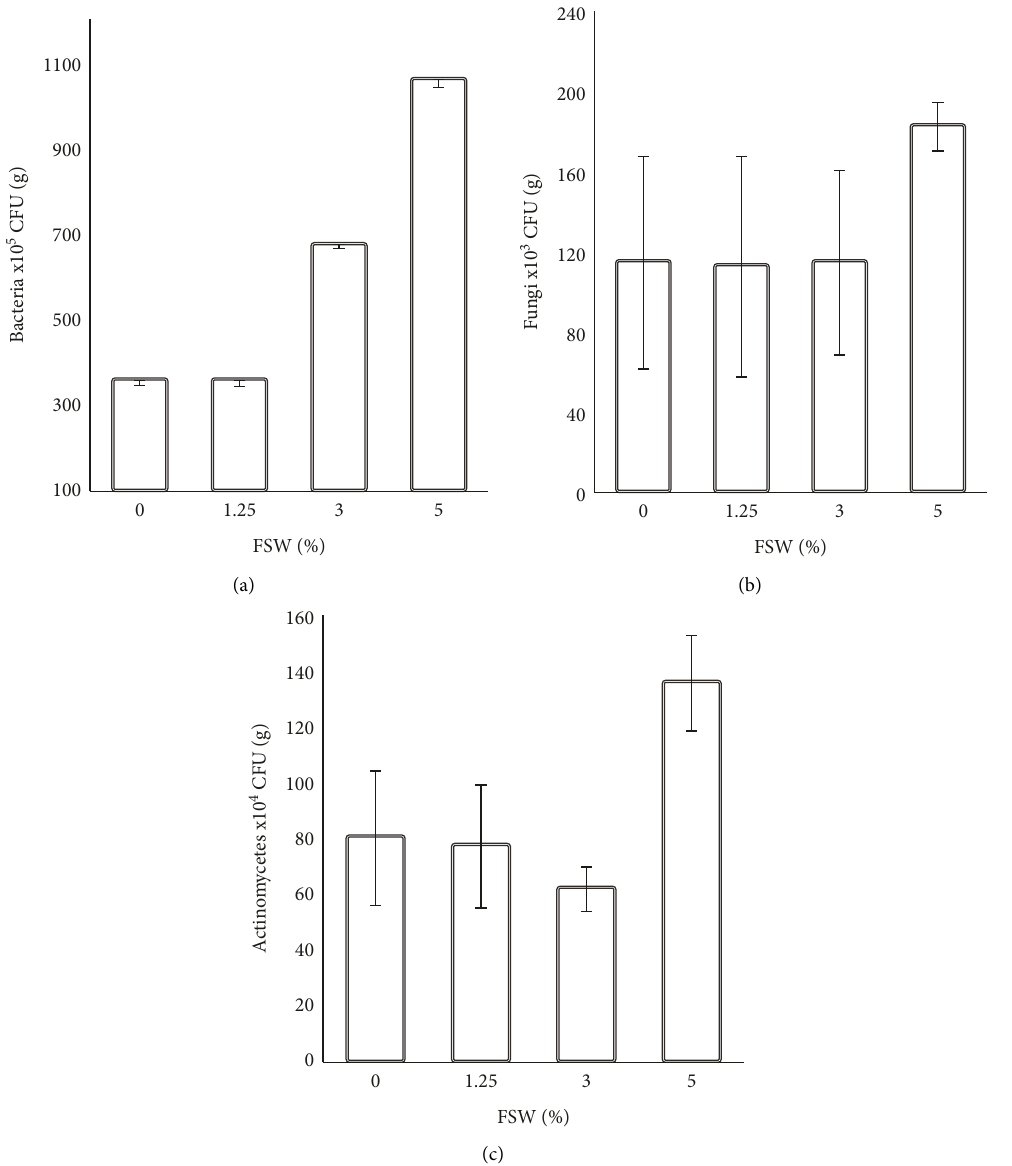
Figure 5: The impact of amendment of different concentrations of the fermented seaweed (FSW) on microbial quantity on the soil (a) bacteria, (b) fungi, and (c)